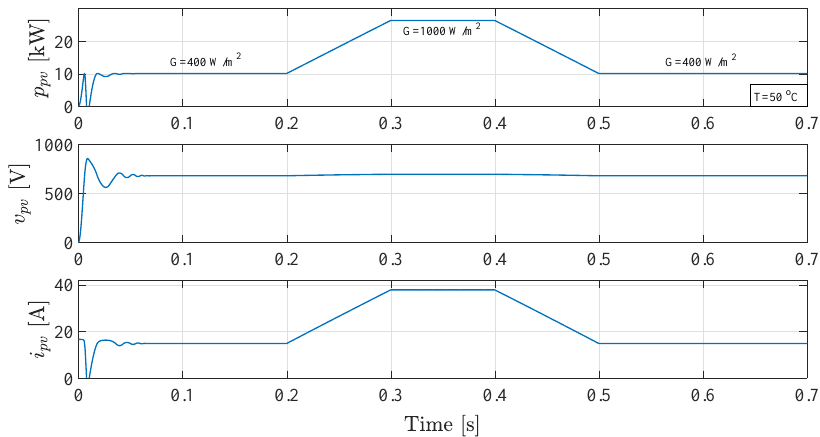
Figure 20. MPPT performance of the proposed model-based technique at 50 ◦ C and gradual radiation change.